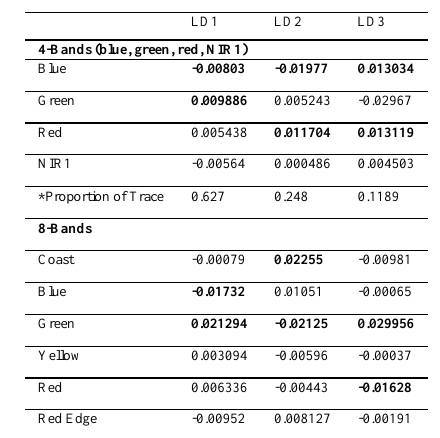
Table 2: Contribution of each spectral band to linear discriminatORS 1,2 and 3 for LDA using 4 (red, blue, green, NIR1)and 8 bands of the Worldview-2 imagery to discriminate between Buffel grass from various other vegetation types